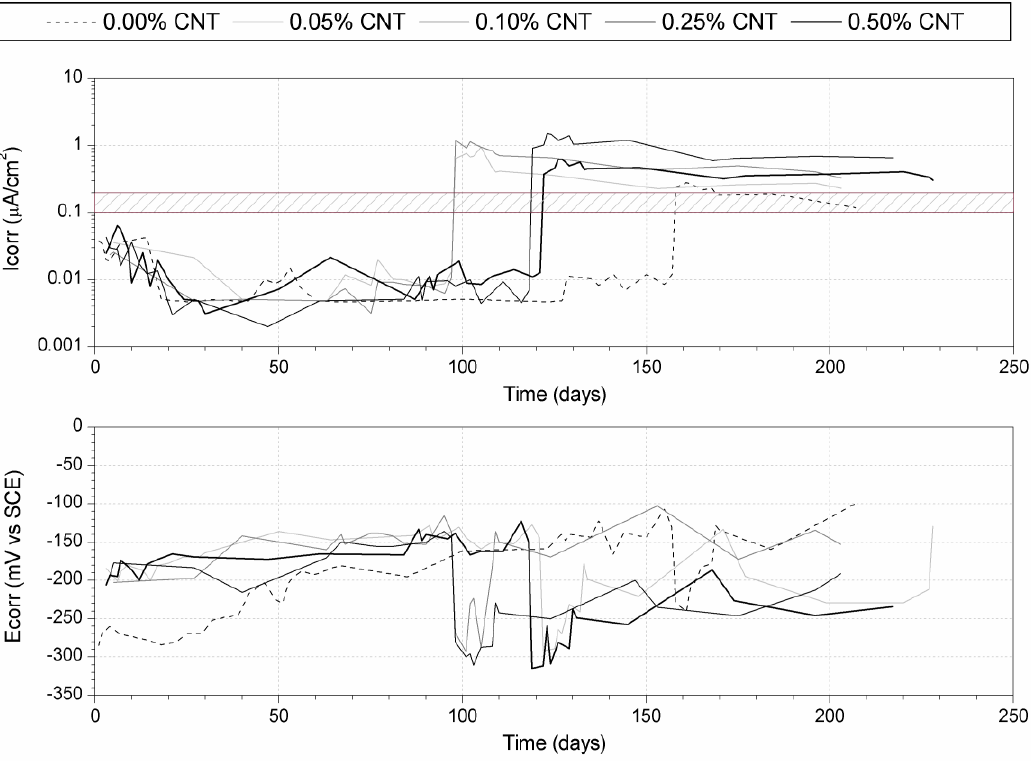
) and corrosion rate ( I ) of steel rebars corr corr